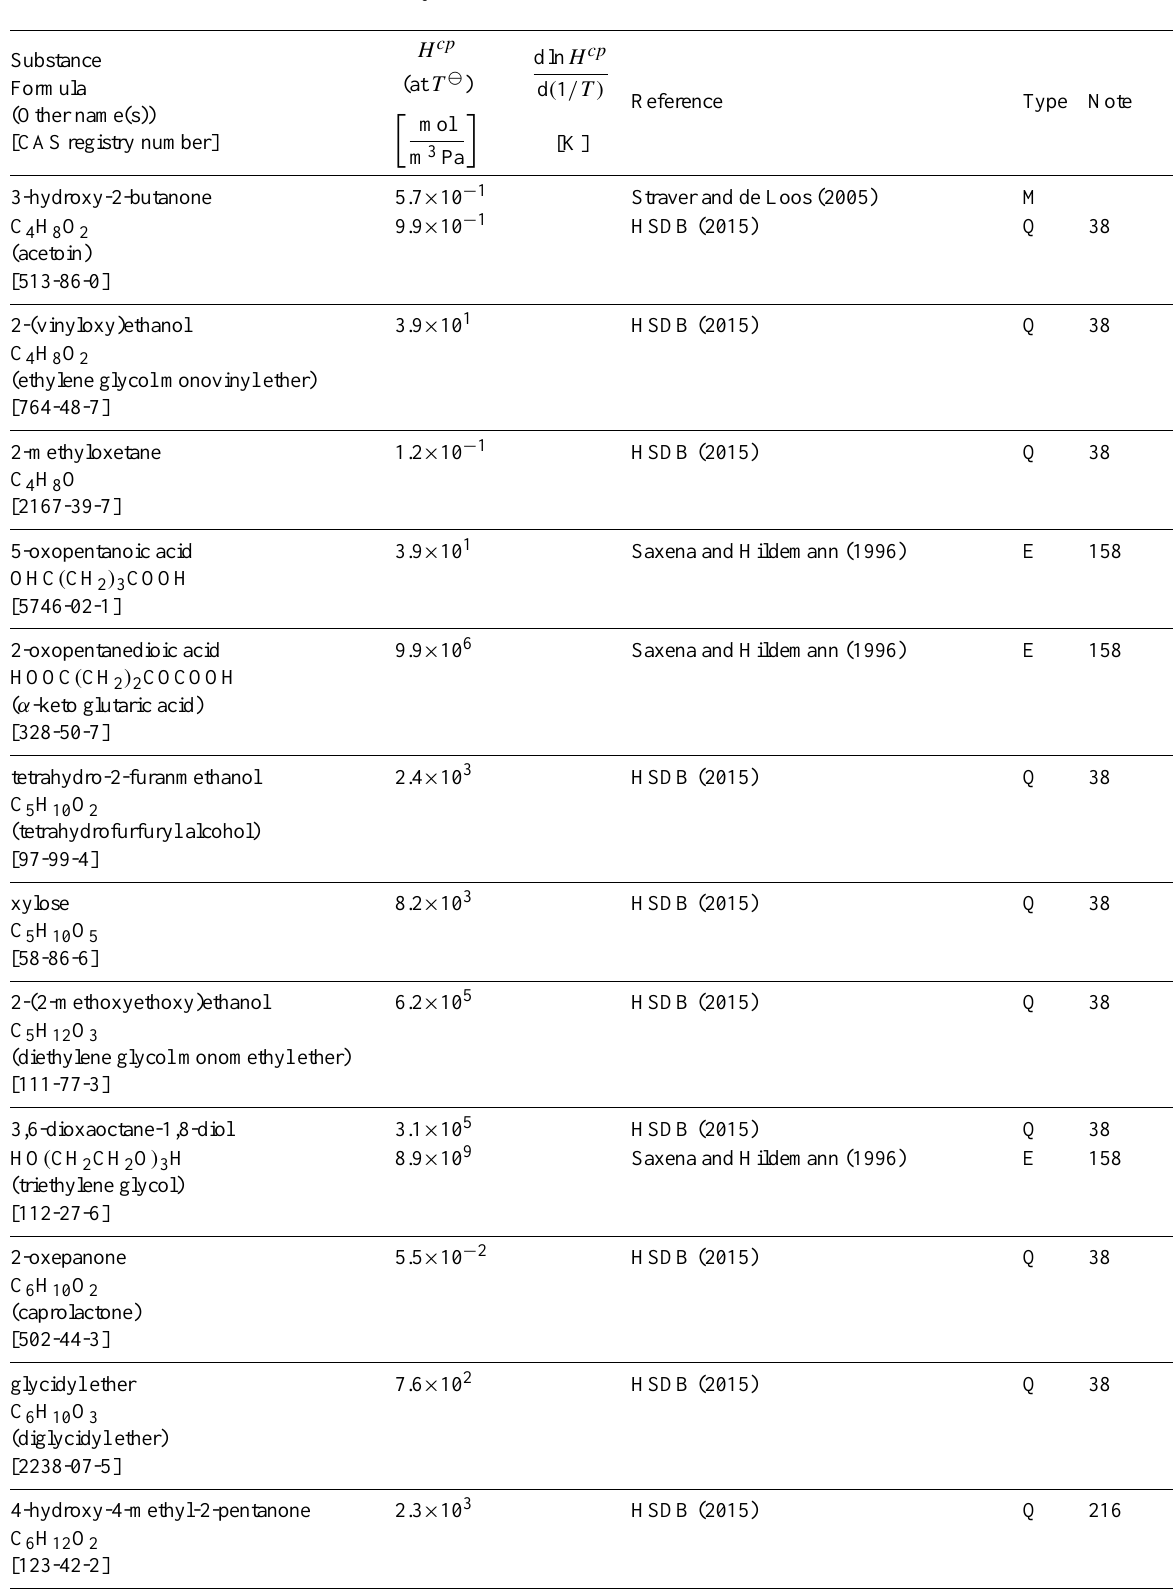
Table 6: Henry’s law constants for water as solvent